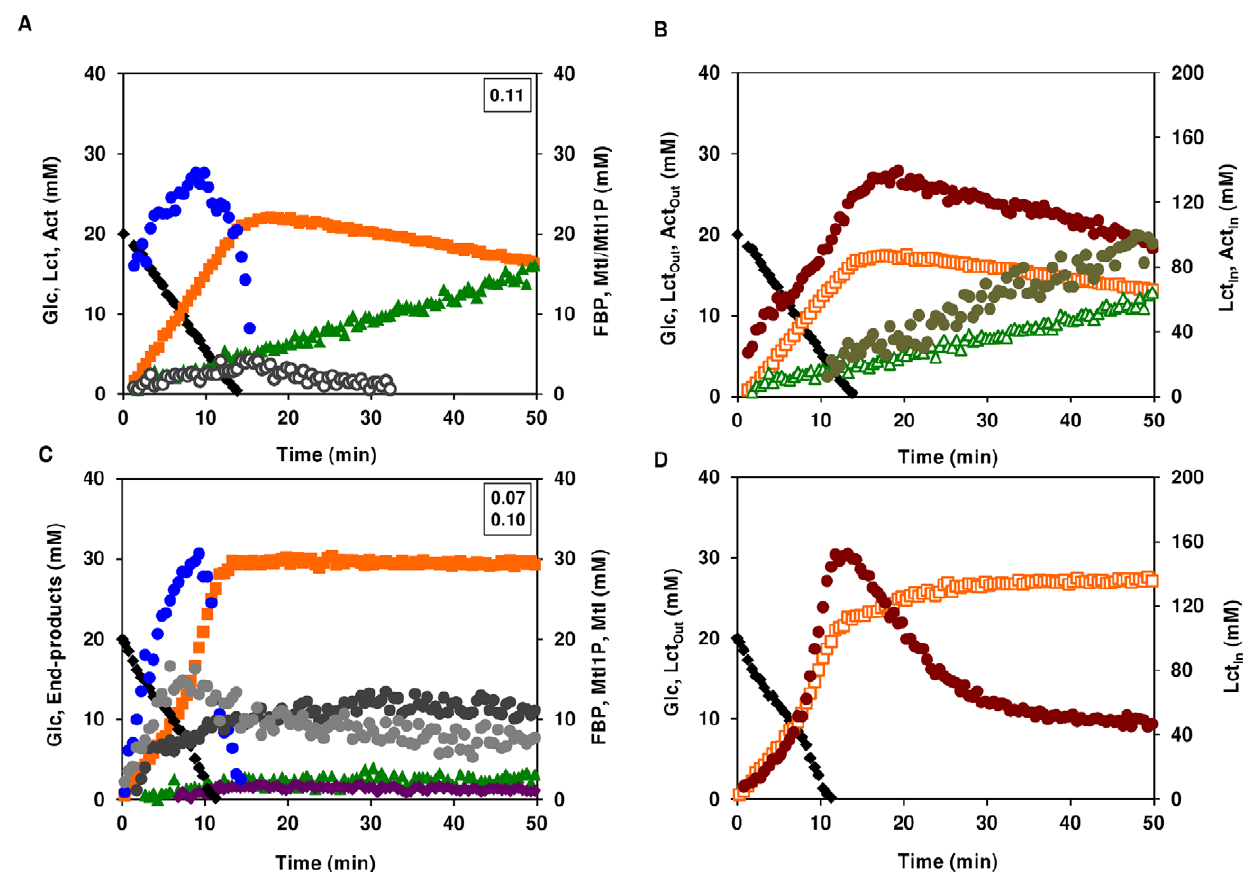
Figure 3. Effect of oxygen limitation on glucose metabolism in aerobically-grown S. aureus . Kinetics of [1- 13 C]glucose (20 mM) consumption, end-products formation and phosphorylated intermediates in resting cells of aerobically-grown S. aureus COL-S under semi-aerobic (A) and anaerobic (C) conditions. Maximal glucose consumption rates ( m mol min 2 1 mg 2 1 of protein) are boxed in the upper-right corners. Dynamics of intra- and extracellular pools of lactate and acetate under semi-aerobic (B) and anaerobic (D) conditions; Glc is also shown for the sake of clarity. Symbols: (black diamond), glucose; (orange square), total lactate; (green triangle), total acetate; (bordeaux diamond), ethanol; (blue circle), FBP; (open orange square) extracellular lactate; (brown circle) intracellular lactate; (open green triangle) extracellular acetate; (olive circle) intracellular acetate; (grey circle) Mtl1P, (dark grey circle) mannitol; (open circle) Mtl1P + mannitol.